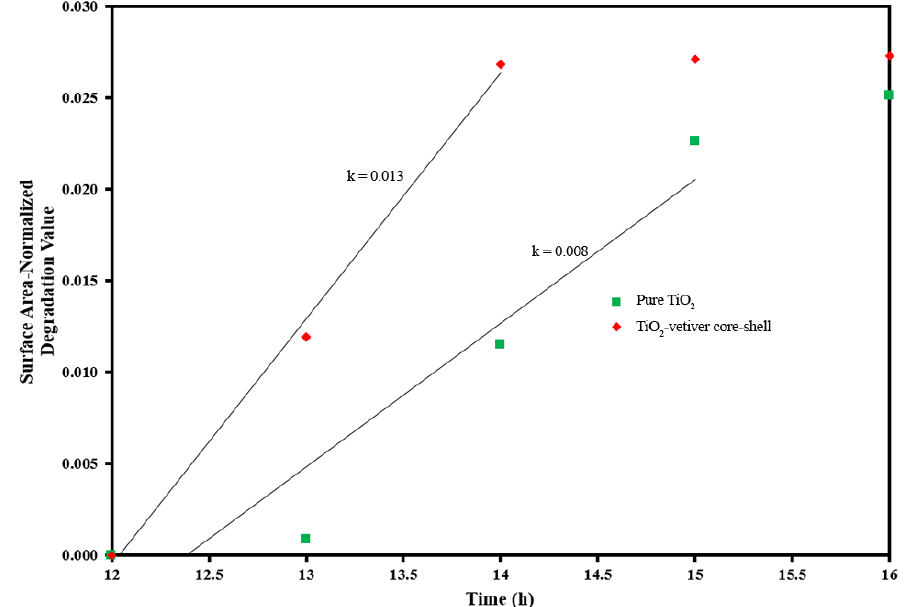
Figure 8. Kinetics plots of the surface area ‐ normalised degradation values against light irradiation time.